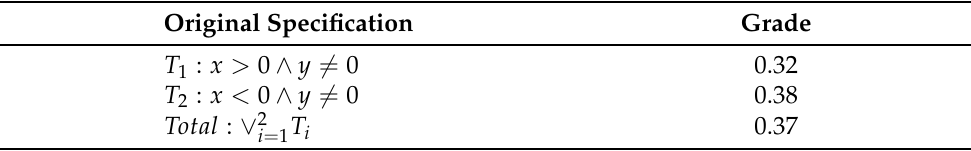
Table 3. Results for process Mod with original